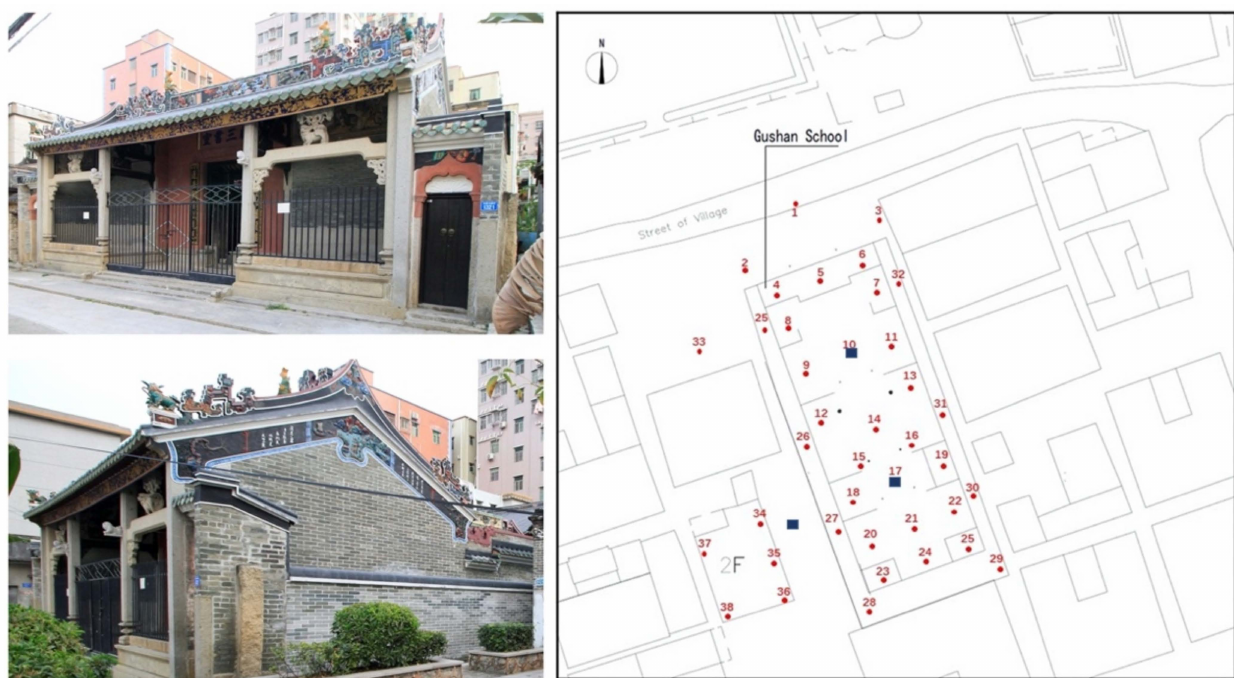
Figure 4. Outdoor scanning arrangement of the Gushan school. In all, there are 36 scanning stations arranged for the outdoor scanning of the Gushan school.